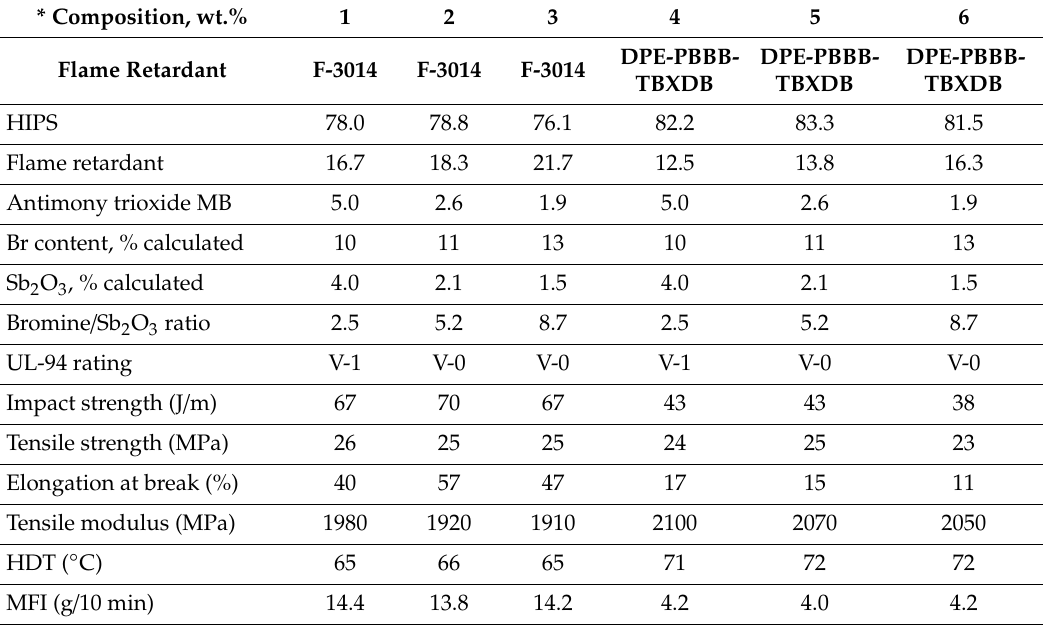
Table 5. Flammability performance and physical properties of